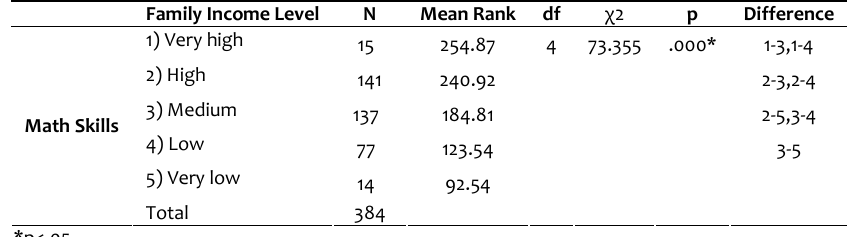
Table 12. Results of Kruskal-Wallis Test Analysis on Math Skills of the 5-Year-Old Preschoolers According to Family Income